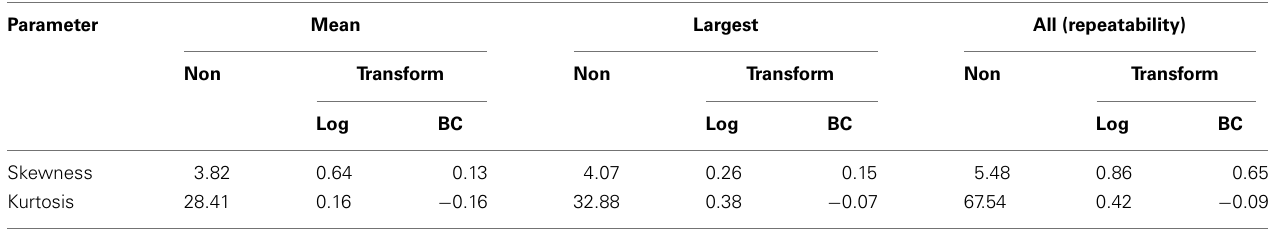
Table 2 |Values of skewness and kurtosis for non-transformed (Non), log, and Box–Cox (BC) transformed data.